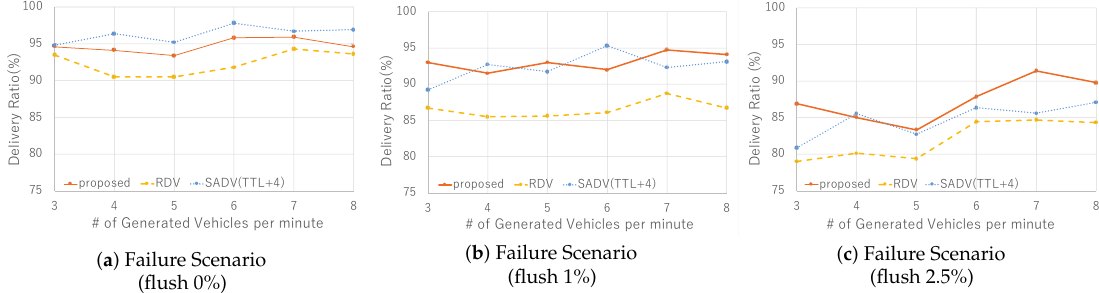
Figure 13. Performance in failure scenario: delivery ratio sensitively degrades as flush rate